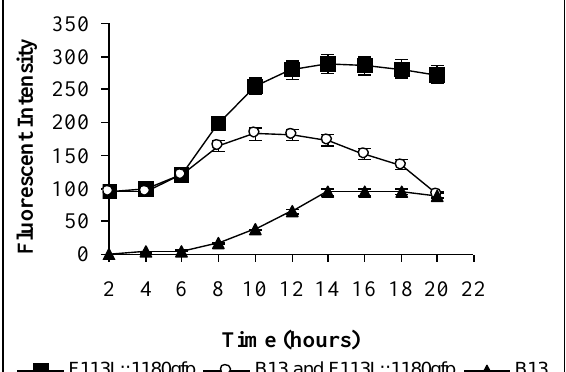
Figure 7. Biosensor detecting 3-CBA degradation by Pseudomonas sp . B13. Gfp fluorescent signal detected using a spectrofluorimeter. Note in the mixed cultivation, fluorescence decreases after 10 hours due to removal/degradation of 3-CBA by Pseudomonas sp.